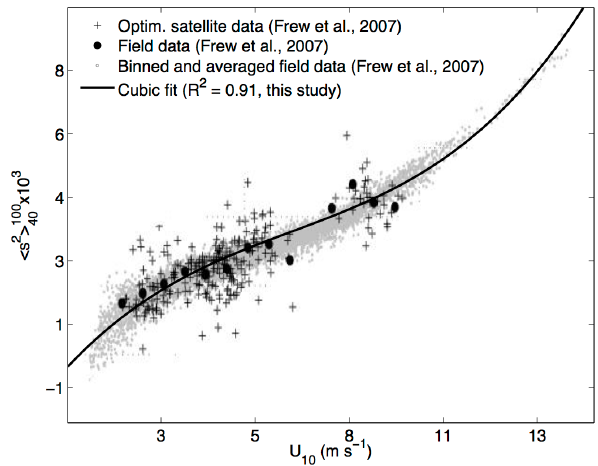
Fig. 5. (top) Wind speed ( U ), ice velocity ( V 0 ) , and the fraction of Figure 5. Top panel: Wind speed (U), ice velocity (V 0 ), and the fraction of open water (f), 3 open water ( f ), calculated along the drift path of ice-tethered pro- calculated along the drift path of Ice-tethered Profiler #3 (ITP 3, http://www.whoi.edu/itp). 4 filer #3 (ITP 3, http://www.whoi.edu/itp). (bottom) The gas trans- Bottom panel: The gas transfer velocity ( k shear ) that would result from shear-driven turbulence. 5 fer velocity ( k shear ) that would result from shear-driven turbulence. Red “+” symbols indicate estimates of k shear that have been affected by stratification. The 6 Red “ + ” symbols indicate estimates of k shear that have been af- speckled color indicates the vertical distribution of N 2 > 10 -4 s -2 , giving a rough approximation of 7 fected by stratification. The speckled color indicates the vertical the mixed-layer depth. Some data gaps exist in the ITP profiles. 8 distribution of N 2 >10 − 4 s − 2 , giving a rough approximation of the mixed-layer depth. Some data gaps exist in the ITP